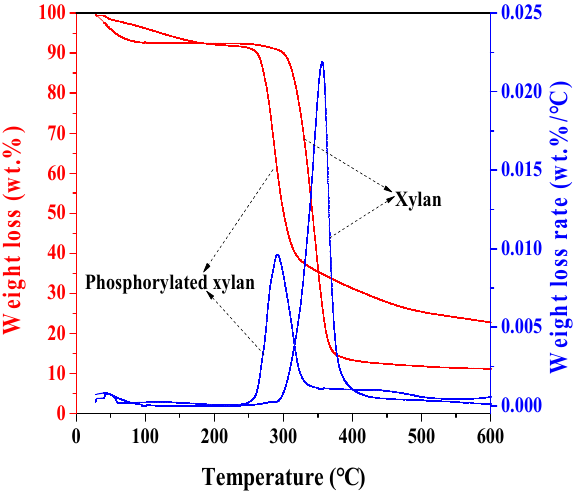
Figure 7. Weight loss and weight loss rate of xylan and phosphorylated xylan.